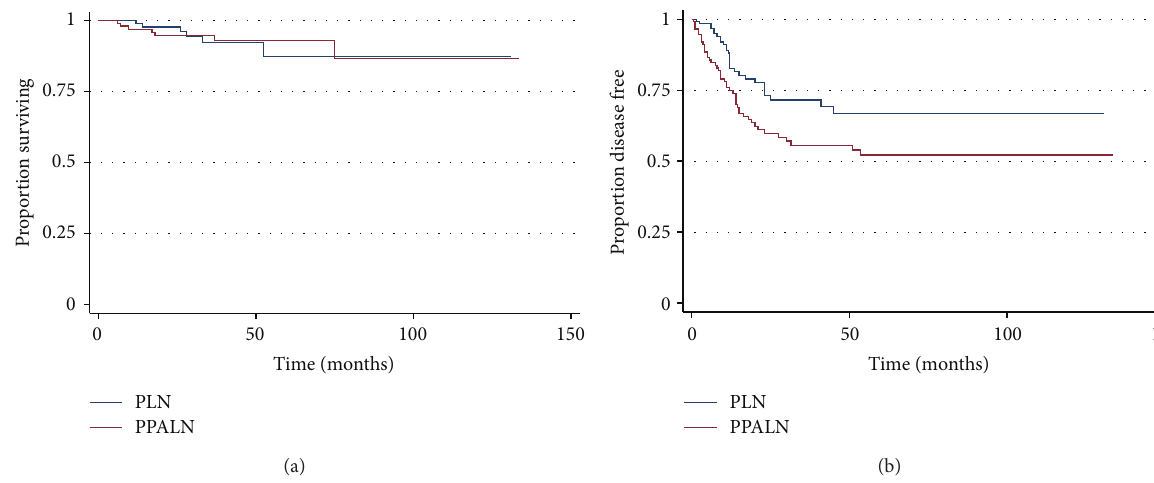
Figure 2: (a) Kaplan-Meier overall survival estimate. Logrank test PLN versus PPALN 𝑃 value = 0.93. (b) Kaplan-Meier Disease-Free survival estimate. PLN versus PPALN Logrank test 𝑃 value =